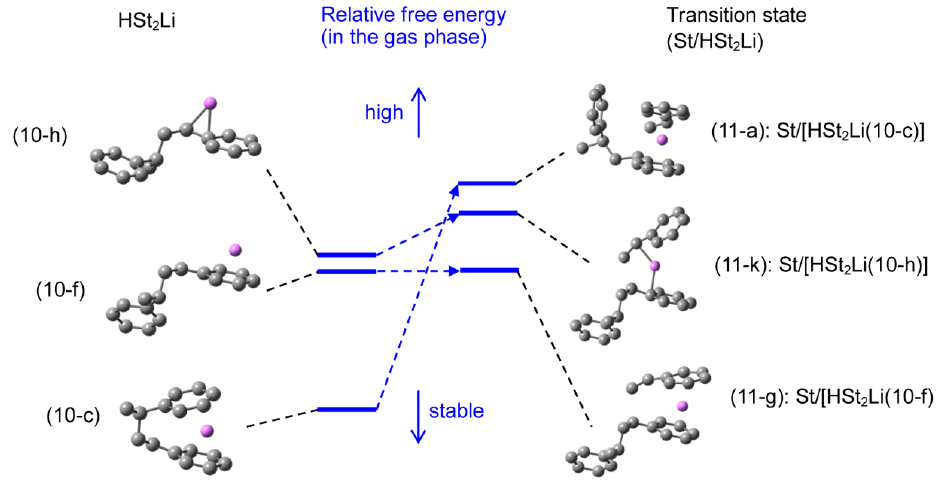
Figure 20. Geometries and relative free energies in the gas phase for the three types of HSt 2 Li and the transition states of their reaction with styrene.